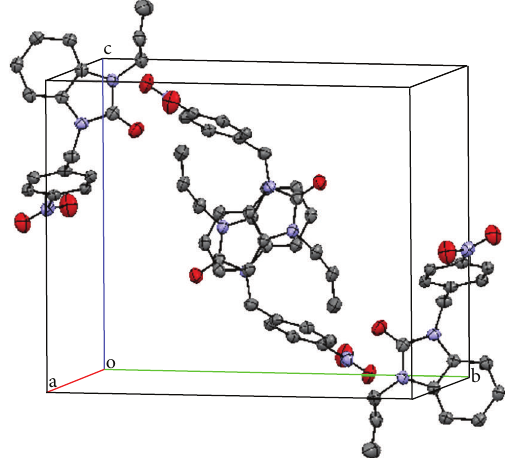
Figure 5: Arrays formed by intermolecular 1H-benzo[d]imidazol- 2(3H)-one–1H-benzo[d]imidazol-2(3H)-one 𝜋 – 𝜋 interactions.